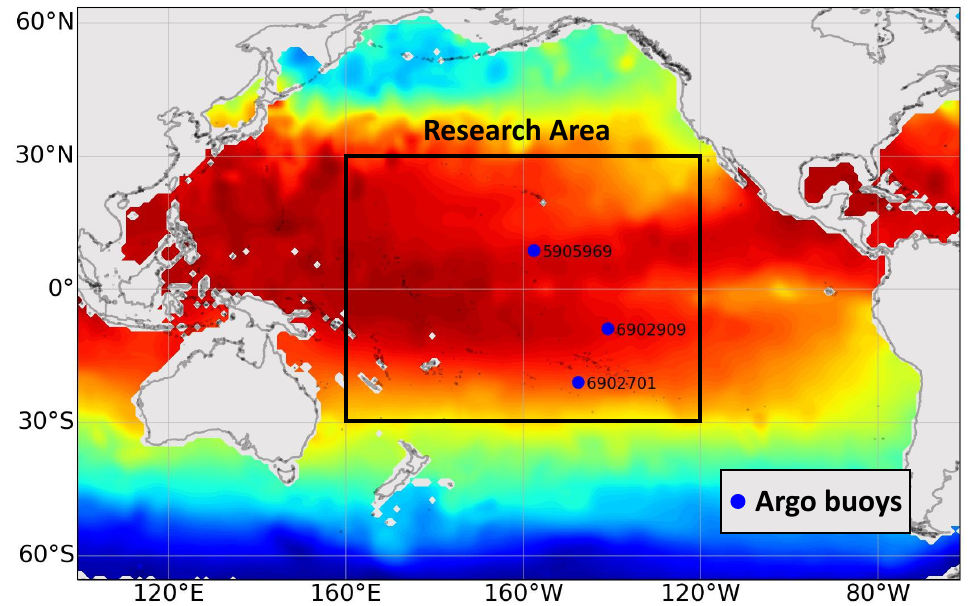
Figure 1. Schematic map of the study area and its zoning, a research area in this study is in the central Pacific (160°E–120°W and 30°S–30°N); the Argo buoys No. 5905969, 6902701, and 6902909 are used for vertical profiles